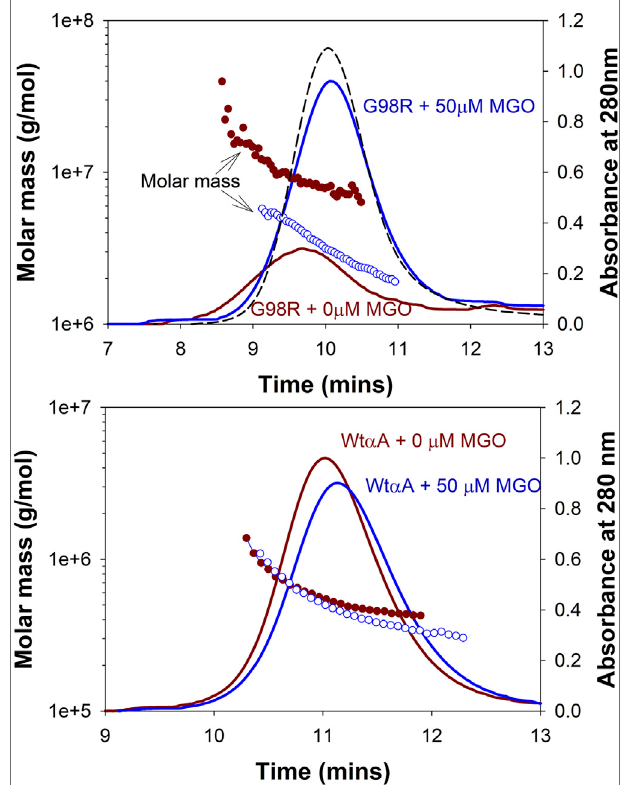
FIGURE 5 | Effect of MGO modi fi cations on the molar mass distribution of α AG98R and α A-WT proteins. The proteins were treated with 50 µM MGO for 7 days. MGO treatment reduces the aggregation propensity of α AG98R protein but does not signi fi cantly affect α A-WT oligomers. The results of light scattering analysis are summarized in Table 2 . The black (curve dashed) is the elution pro fi le of untreated α AG98R at 0 min. The protein concentration of this peak reported from the RI detector is considered 100% recovery for mutantprotein.The α A-WTpeakat0 minoverlappedwiththe( α A-WT+0 mM MGO) peak and is not shown.